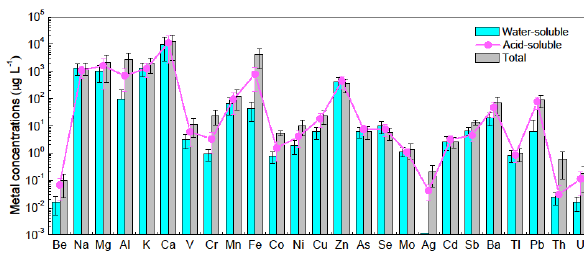
Figure 2. The elemental abundance and fractions of precipitation collected in